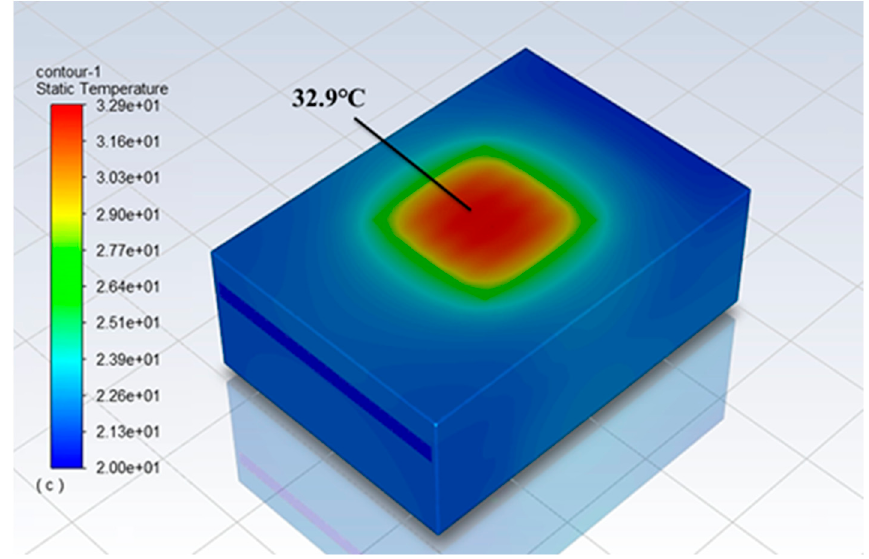
Figure 12. Temperature cloud diagram of double-layer reflux microchannel.